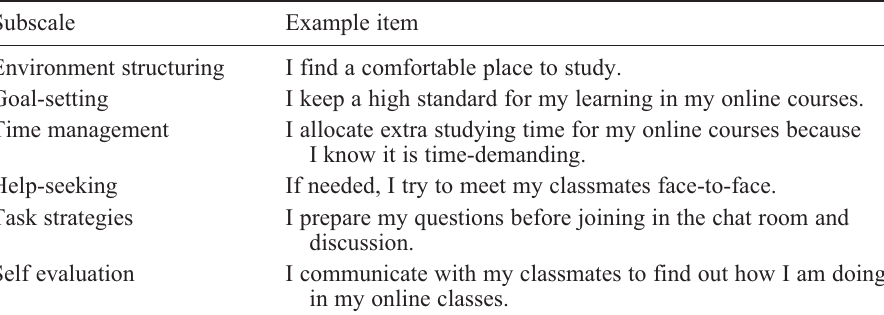
Table 2. Example Item from each subscale. Subscale Example